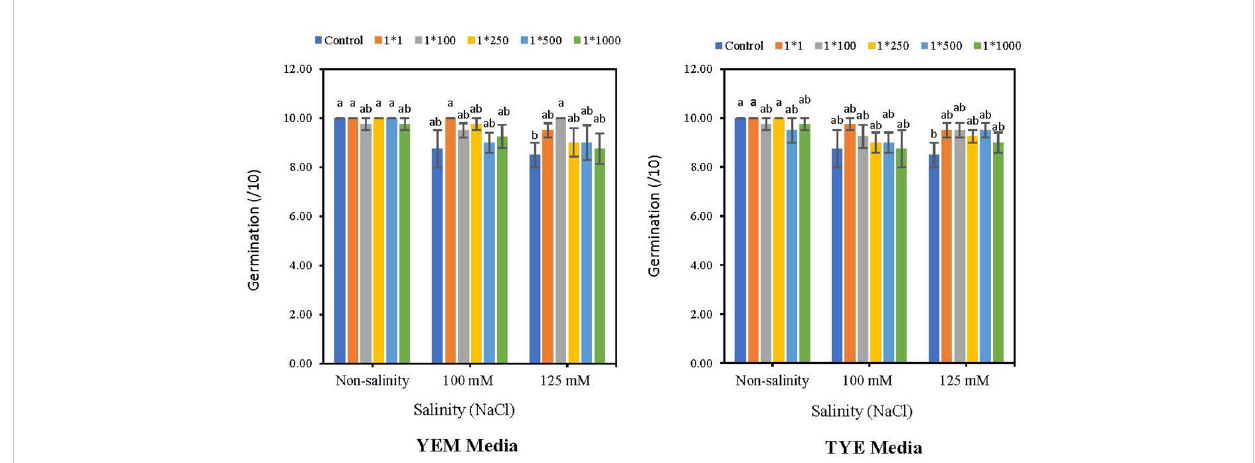
FIGURE 4 Effect of dilutions of Devosia sp. YEM(B)-CFS and TYE(B)-CFS and salinity on germination of soybean seedlings. Values represent the mean of four replicates ± SD. 1:1, 1:100, 1:250, 1:500 and 1:1000 = 1 mL Devosia sp. CFS and 1, 100, 250, 500 and 100 mL distilled water,